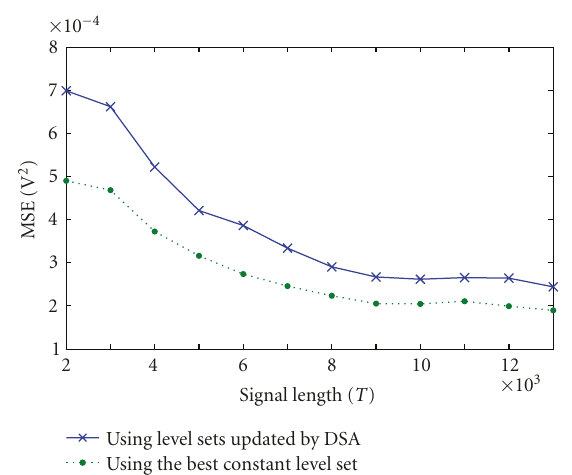
Figure 5: The performance of the discrete-time sequential algo- rithm described in Section 2. The performance is measured by normalized MSE and compared to the performance using the best constant level set known in hindsight.